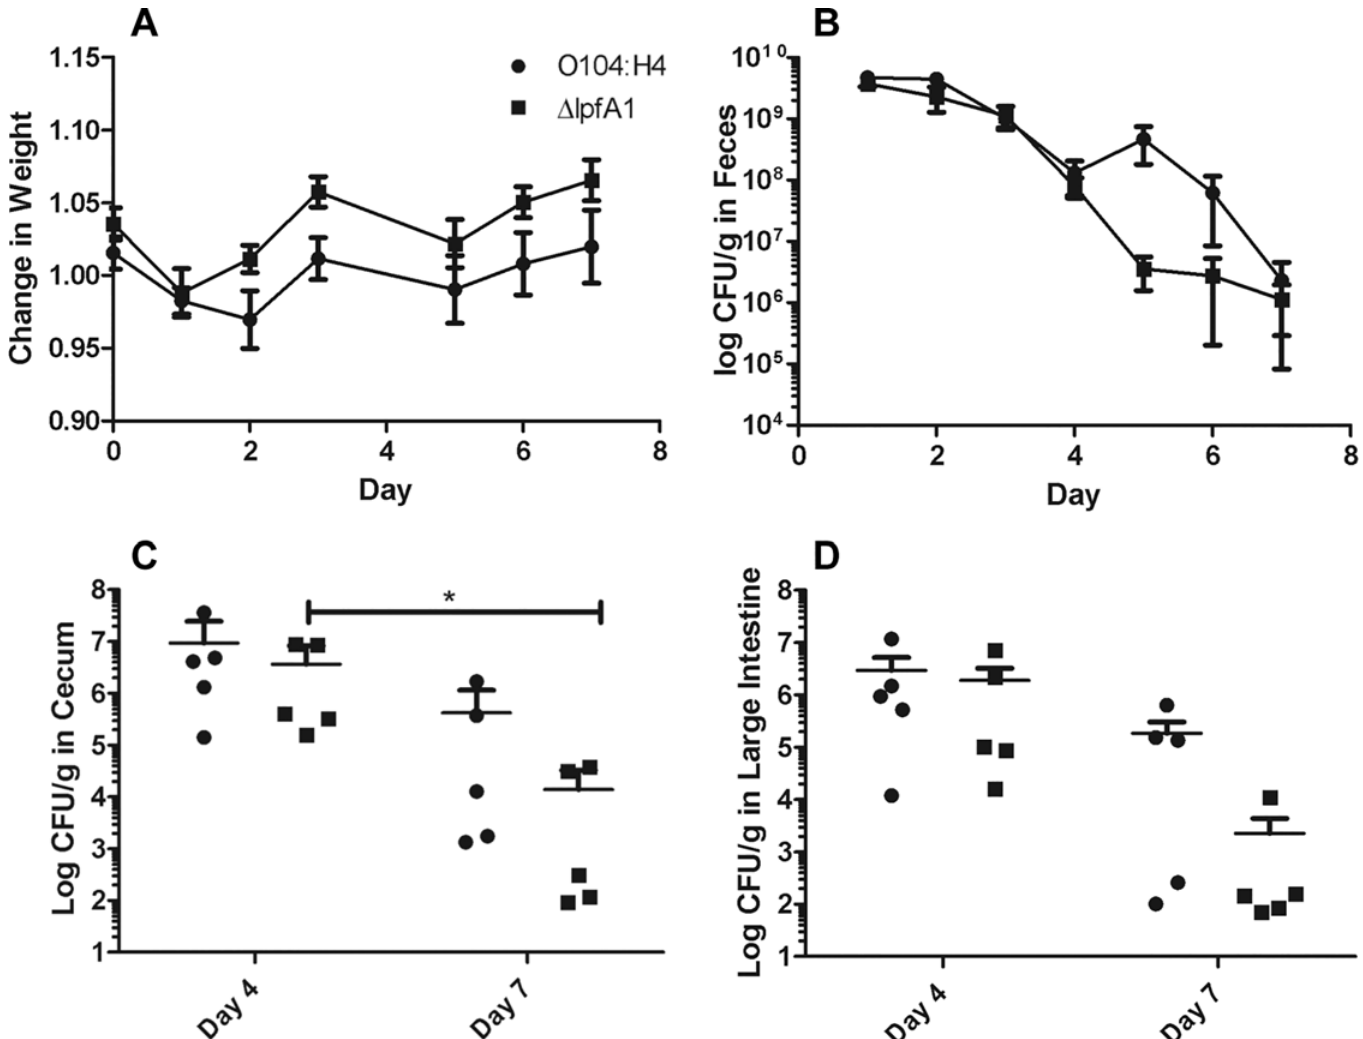
Fig 5. In vivo colonization of mice by wild type O104:H4 and Δ lpfA1 . Six to eight week old CD-1 ICR mice were infected with 1x10 9 O104:H4 2011 c3494 wild type (n = 10) or Δ lpfA1 (n = 10). Their weight (A) fecal shedding (B; expressed as log CFUs/g) were monitored for 7 days. On days 4 and 7, ceca (C) and large intestines (D) where collected and bacteria recovery is expressed as log CFU/g of tissue. Error bars indicated SEM of 5 or 10